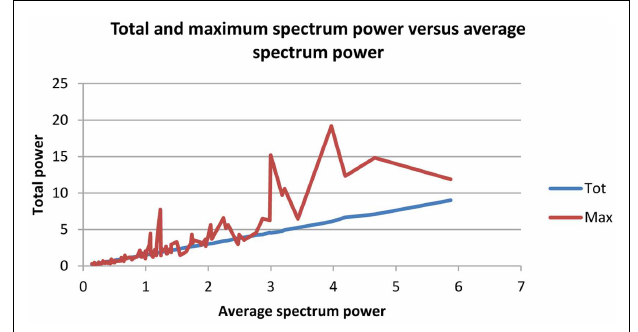
FIGURE 1 | Red line: mean of total potential of alpha/theta ratio of spectrum; yellow line: mean of maximum potential of alpha/theta ratio of spectrum .